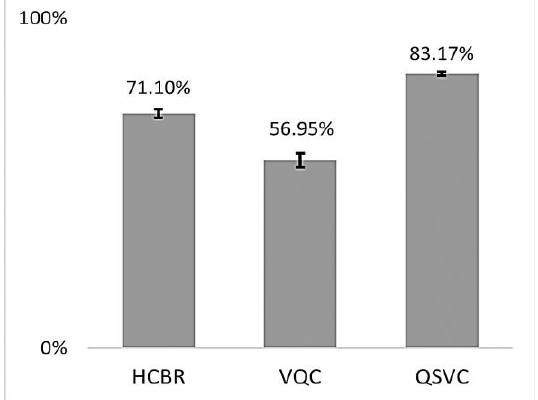
Figure 7. Mean balanced accuracies (in %) of HCBR, VQC, and QSVC achieved during training for all subjects. The vertical black bars show the standard